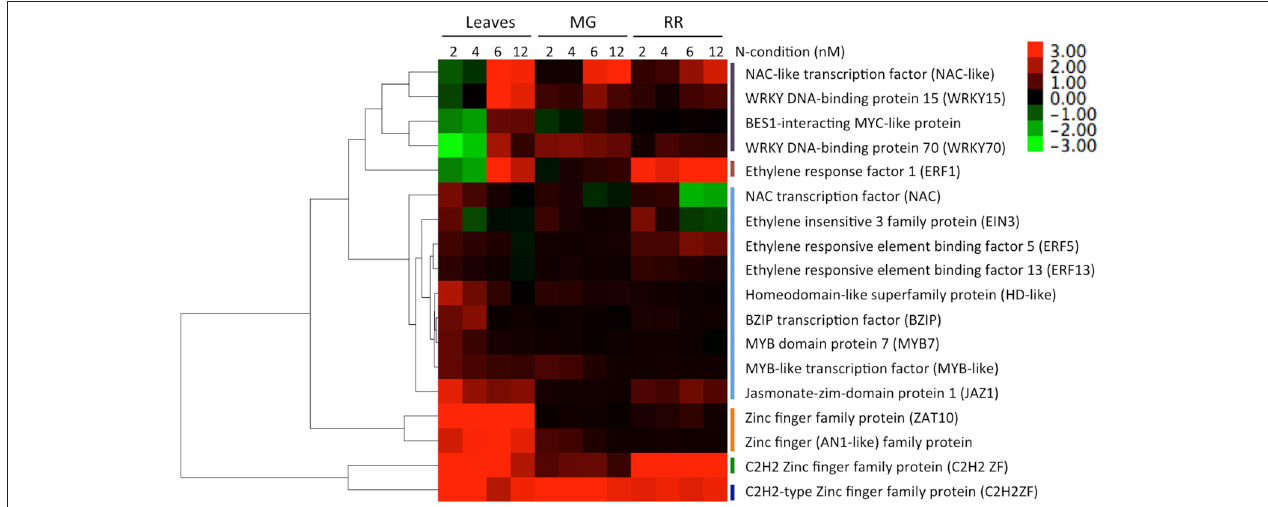
FIGURE 6 | Hierarchical clustering of mRNA levels for selected TFs showing a differential gene expression pattern in response to the fungus infection under different N conditions. The dendrogram and colored image were produced using gene expression data after RT-qPCR ( n = 3 ). The color scale ranges from saturated green for log 2 ratios − 3.0 and below, to saturated red for log 2 ratios + 3.0 and above. Fold change in gene expression for each gene upon B. cinerea infection are referred to mock-treated samples. Each TF is represented by a single row of colored boxes. Six clusters were identified, and are numbered and denoted with a vertical line (from top to bottom) as follows: cluster #1 in gray, #2 in brown, #3 in light blue, #4 in orange, #5 in green, and #6 in